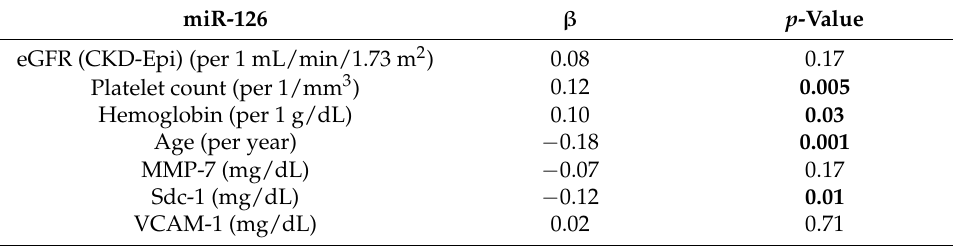
Table 2. Multiple linear regression analysis of endothelial markers independently associated with circulating levels of miR-126. miR-126 β p -Value eGFR (CKD-Epi) (per 1 mL/min/1.73 m 2 ) 0.08 0.17 Platelet count (per 1/mm 3 ) 0.12 0.005 Hemoglobin (per 1 g/dL) 0.10